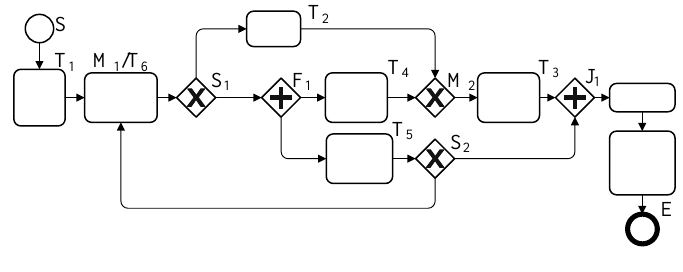
Figure 24. Example workflow for the comparison of the analysis